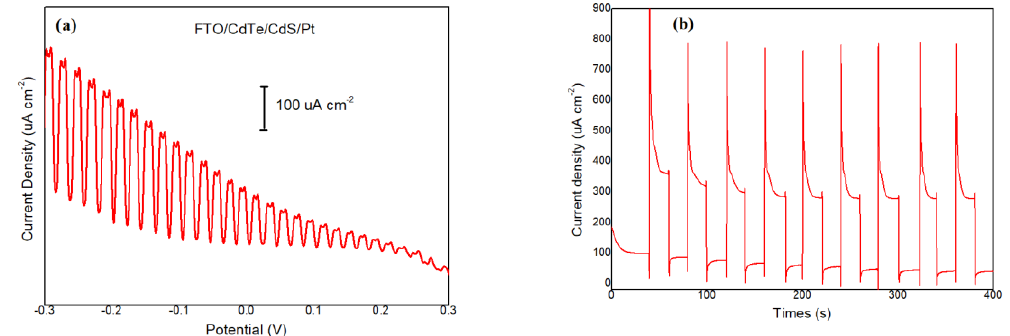
Figure 6. ( a ) Current-potential curves of the Pt / CdS / CdTe / FTO structure; ( b ) current–time curves of the Pt / CdS / CdTe / FTO structure.